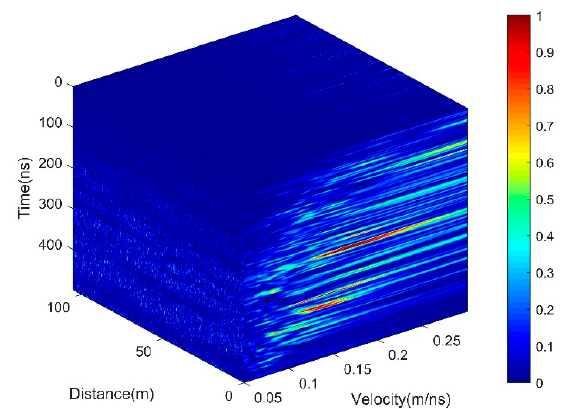
Figure 5. 3D velocity